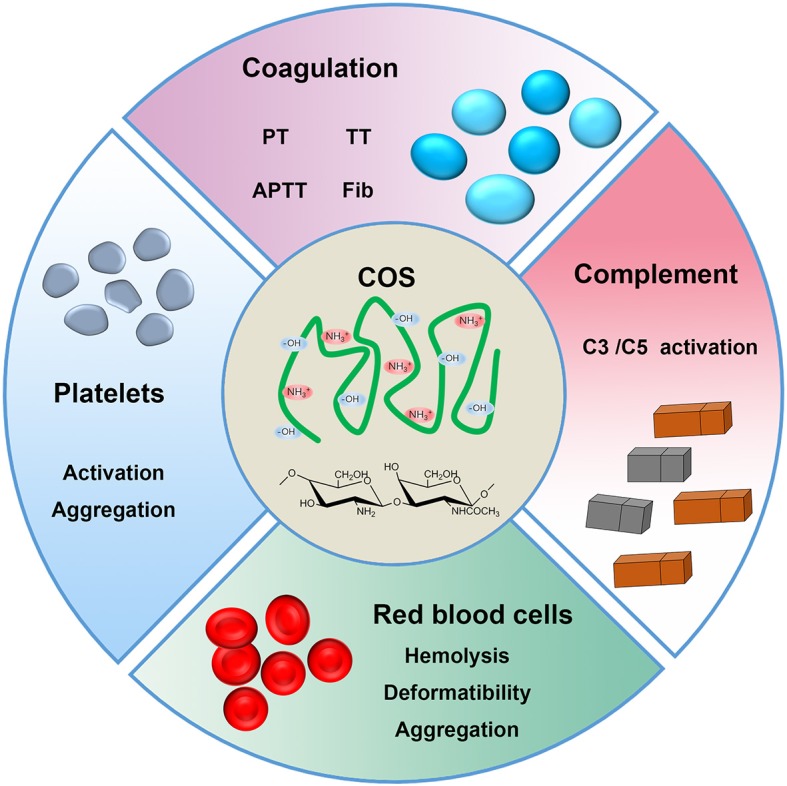
Schematic presentation of COS and blood components.